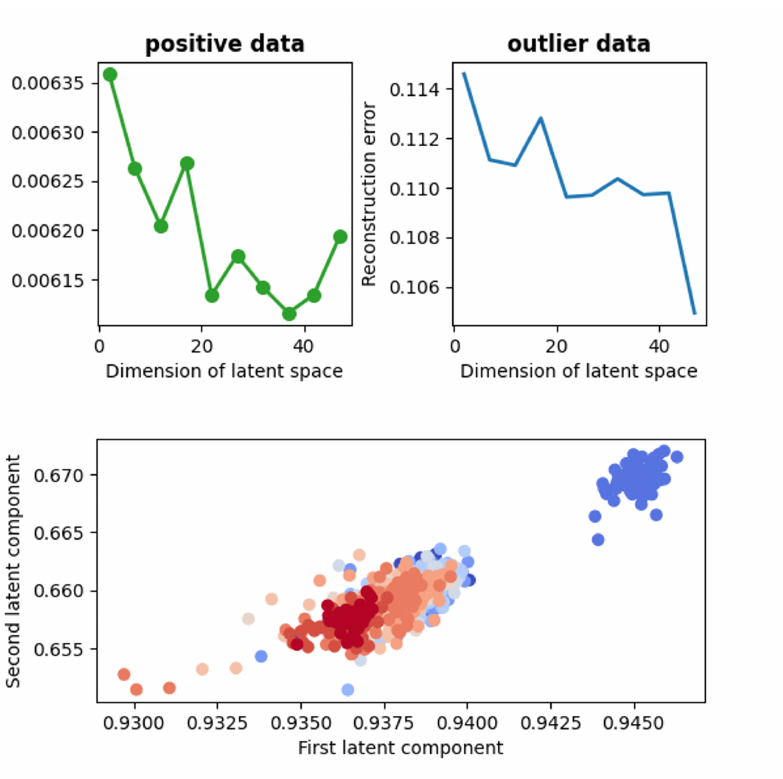
Figure 7. The representation of the applied technique of anomaly detection. The plot at the bottom shows the representation of the data corresponding to the fibroblast cell line at 40 V in 2-dimensional space after its compression with the autoencoder. Different colors in the figure correspond to the independent patches of the same cell line. Each dot represents a 1000-data-points-long subseries from the original recording. As one can see, within the recordings represented by the dark blue dots and the orange ones there were some intervals where the activity of the channel stands out from its typical characteristics represented by the cluster at the top (dark blue) and some orange dots at the left bottom. These outstanding points are called here “outliers”. The plots on the top illustrate the reconstruction error dependence on the dimension of the latent space for positive (typical) and outlier data,